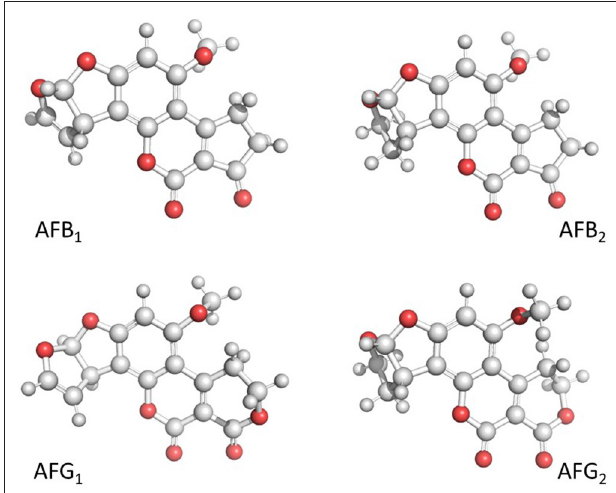
FIGURE 1 | 3D visualization of the chemical structure of aflatoxin B 1 (AFB 1 ), aflatoxin B 2 (AFB 2 ), aflatoxin G 1 (AFG 1 ), and aflatoxin G 2 (AFG 2 ). Created with